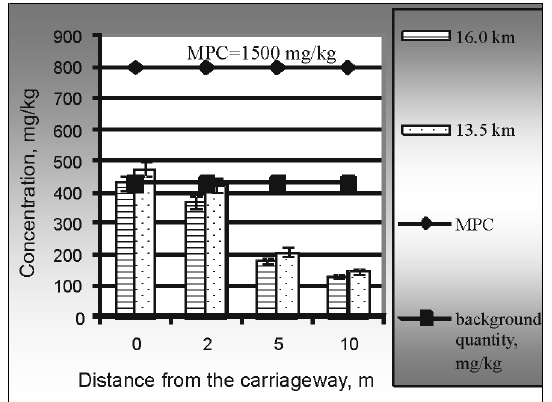
Fig. 4. Manganese concentration in the roadside soil of